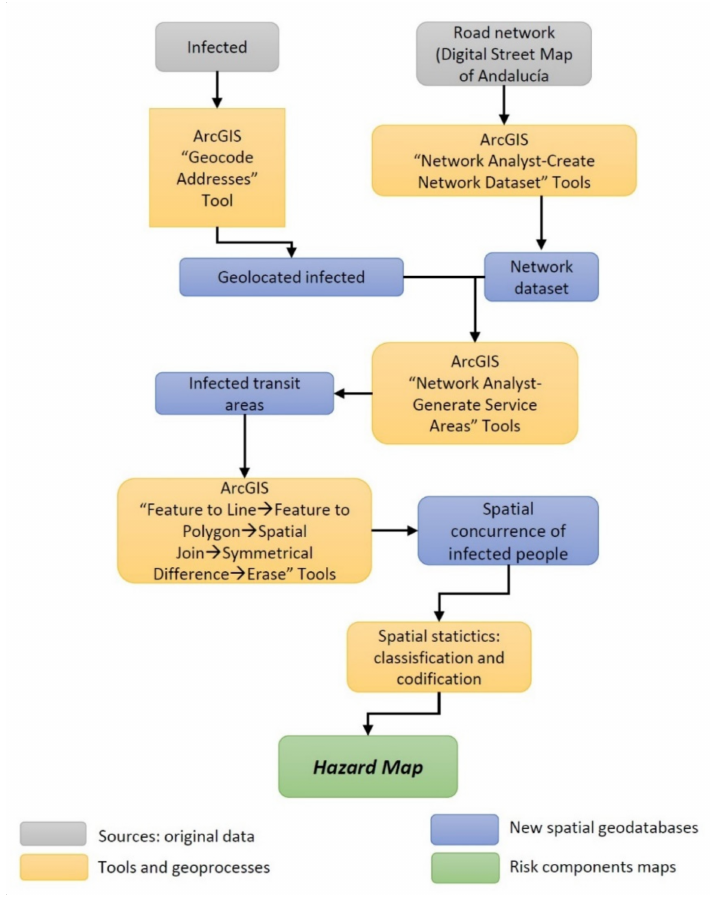
Figure 1. Flowchart of the hazard map. Own